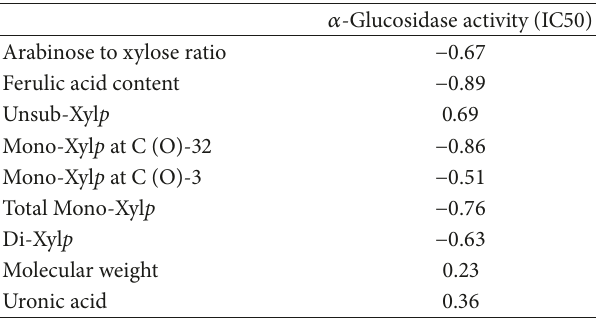
Table 3: Correlation coefficient of arabinoxylans’ inhibition of 𝛼 - glucosidase activity and its structural properties.